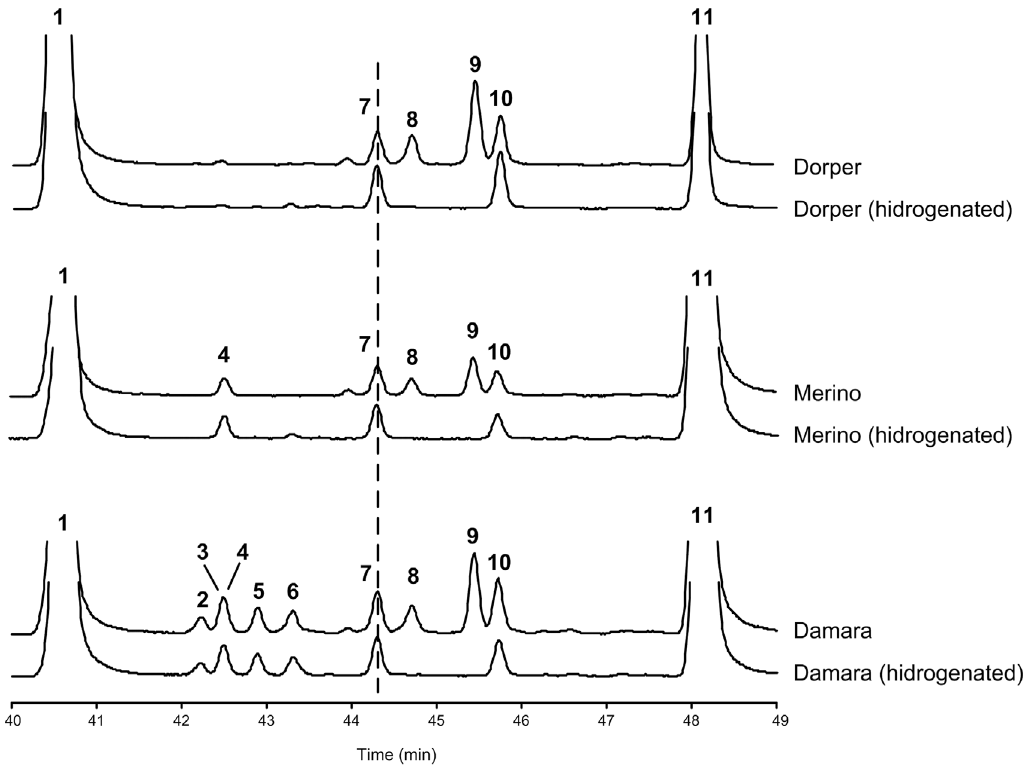
Figure 4. Partial gas-liquid chromatograms of the branched chain fatty acid region of gastrocnemius muscle samples of Damara, Merino and Dorper Ram lambs, before and after hydrogenation of the unsaturated fatty acids. Peak identification: 1) 16:0; 2) 16:0–6Me; 3) 16:0–8Me; 4) DMA-17:0; 5) 16:0–4Me; 6) 16:0–12Me; 7) i-17:0; 8) 16:1 cis- 7; 9) 16:1 cis- 9; 10) a-17:0; 11) 17:0.